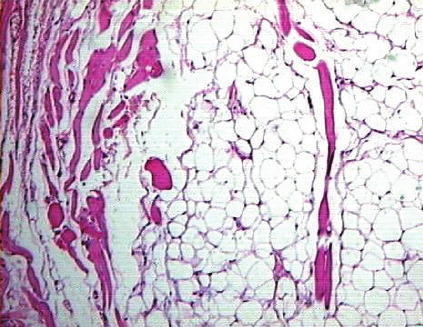
Figure 4: Microscopic view showing the characteristic